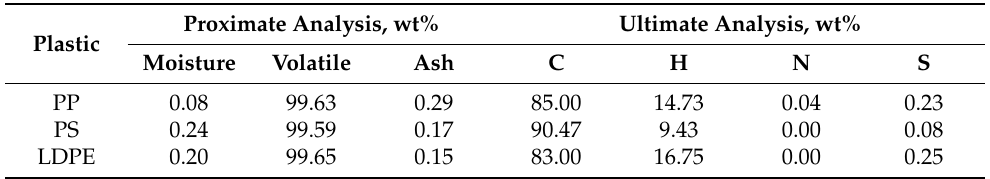
Table 1. Proximate and ultimate analysis of the used plastics.